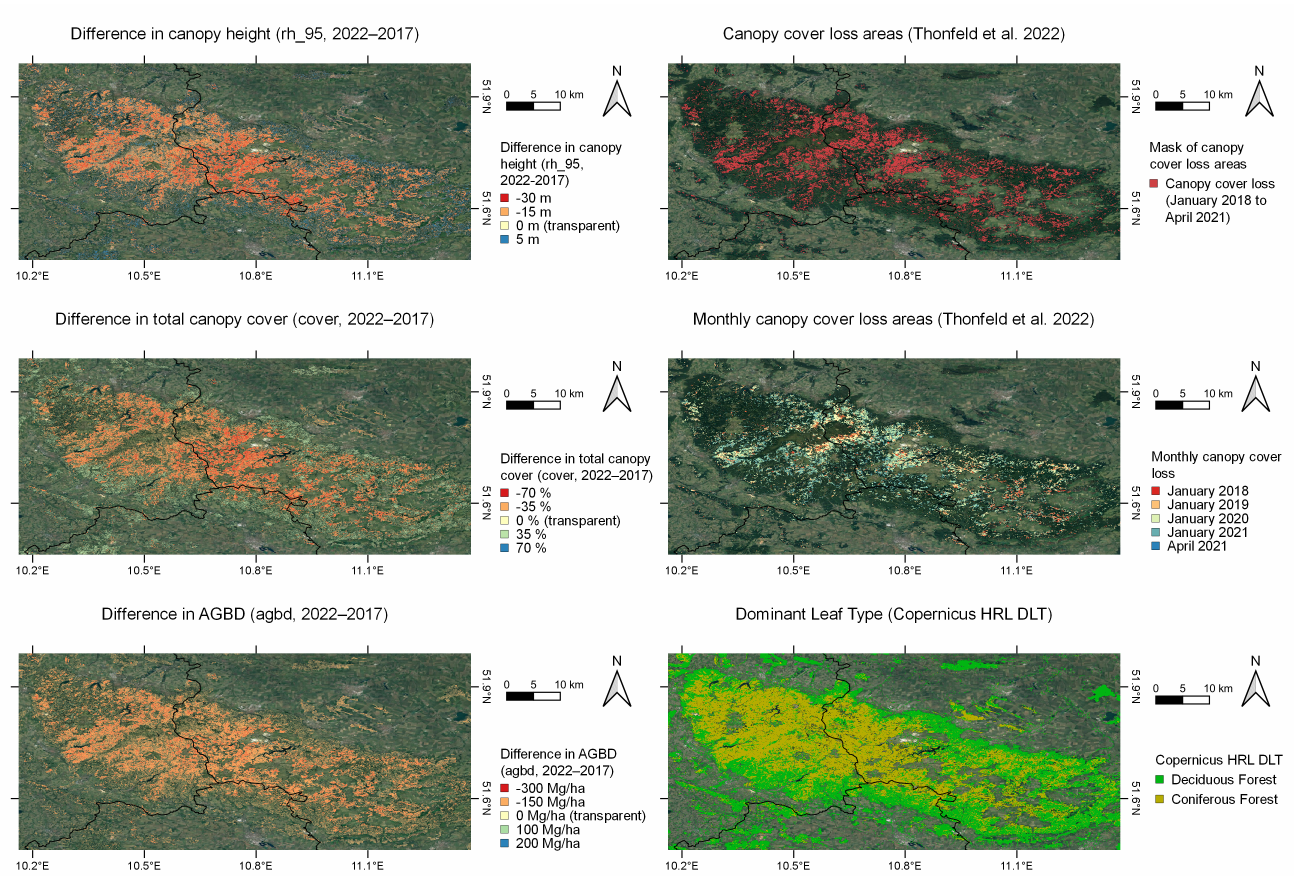
Figure 9. Difference in forest structure (2022–2017) in the Harz region reveals corresponding spatial patterns in canopy cover loss areas detected by Thonfeld et al., 2022